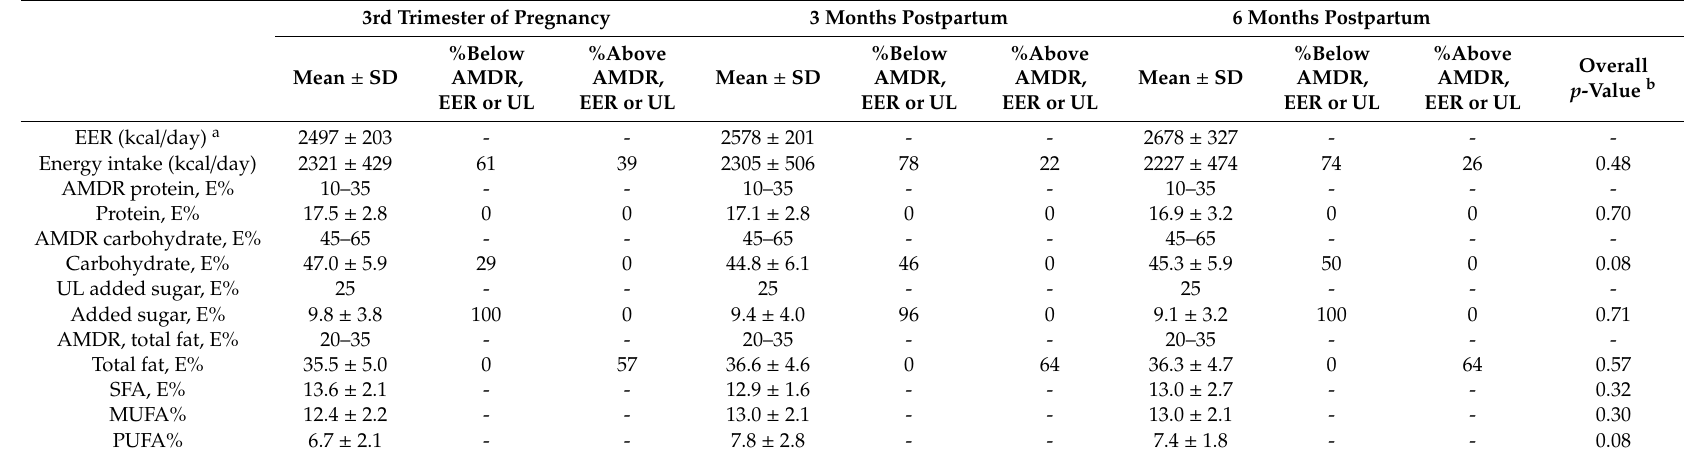
Table 2. Period-specific energy and macronutrient intakes as percentages of energy intake in comparison with dietary reference